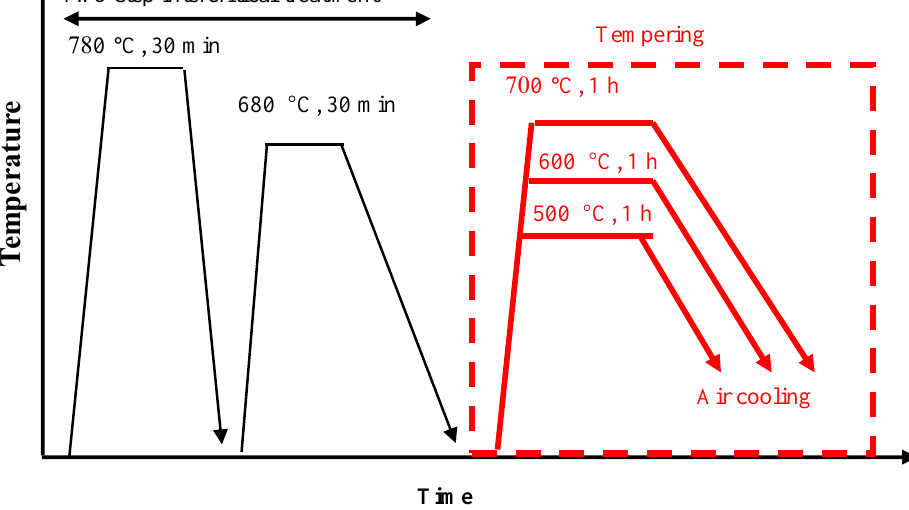
Figure 1. Schematic diagram of the heat treatment in this work.